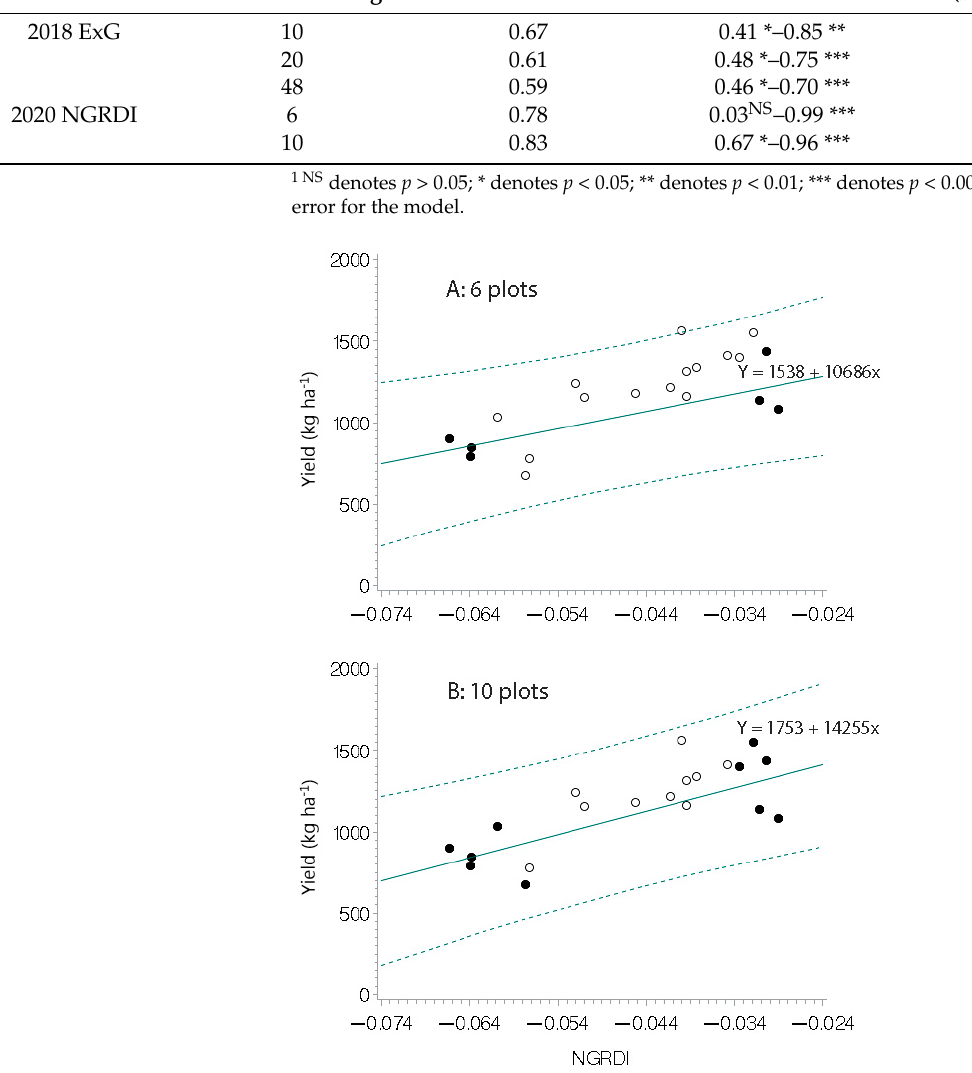
Figure 4. Linear regression models (solid line) with prediction intervals (dotted lines) for specific VI values based on an increasing number of plots in 2020. The model in A is based on 6 plots and B is based on 10 plots. Plots used in the regression analyzes are denoted with dots and validation plots are denoted with open circles. The selection of training data was based on extreme NGRDI values.